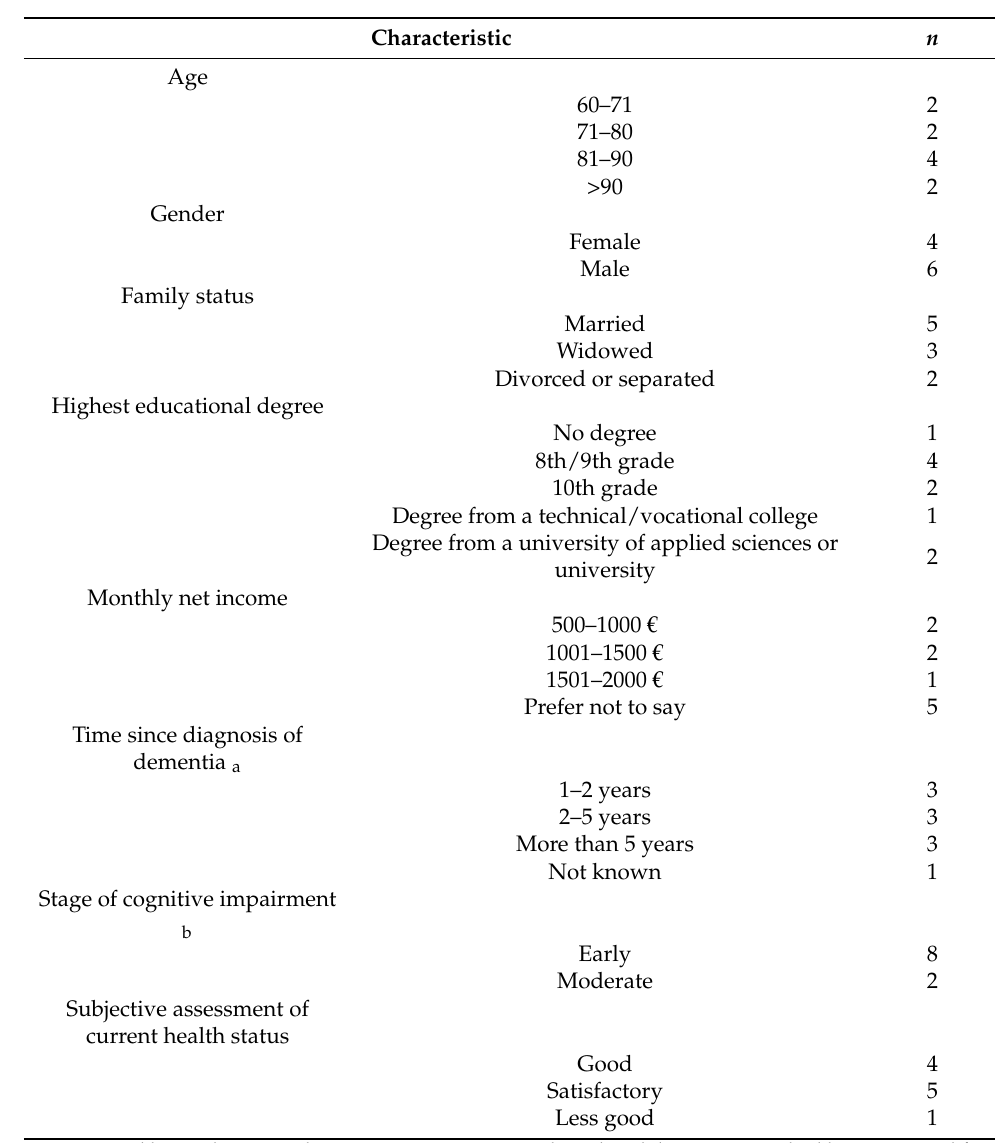
Table 2. Patient Characteristics ( n =